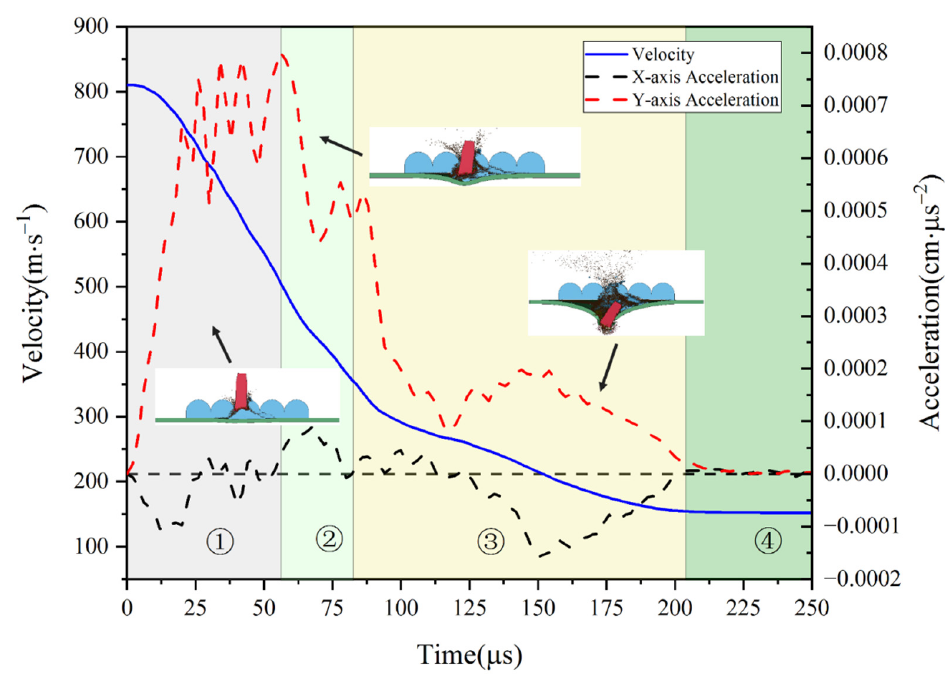
Figure 11. Projectile velocity and acceleration vs time curves ( η = 0.5).